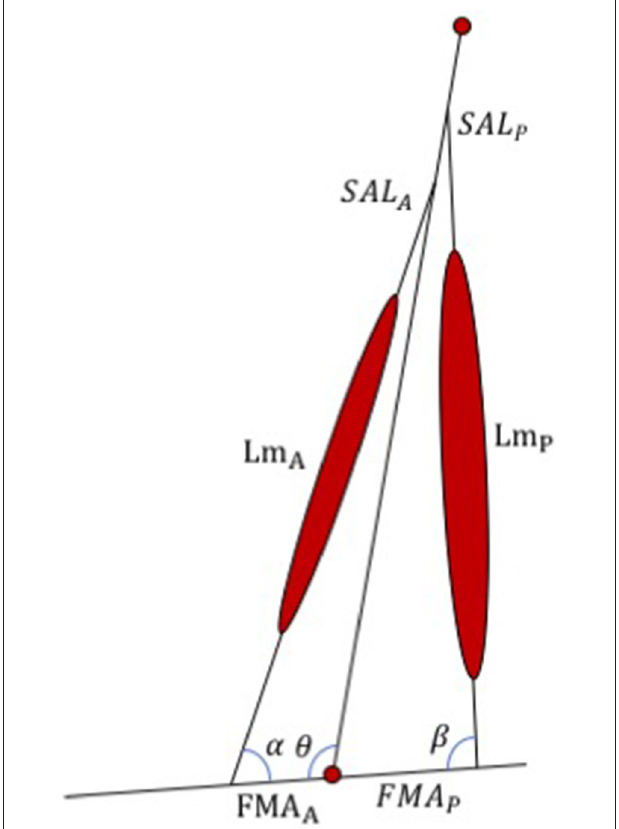
FIGURE 2 | Schematic representation of the WFH algorithm developed for the BiOM prosthesis. The algorithm consists of an anterior and a posterior muscle (represented by WFH muscle models, see Figure 1 ) with lengths (Lm A and Lm P ), foot moment arms (FMA A and FMA P ), shank attachment lengths (SAL A and SAL P ), and muscle attachment angles ( α , β ) determined from published values or calculated using geometry (see Table 1 ). θ = ankle joint angle. See text for further